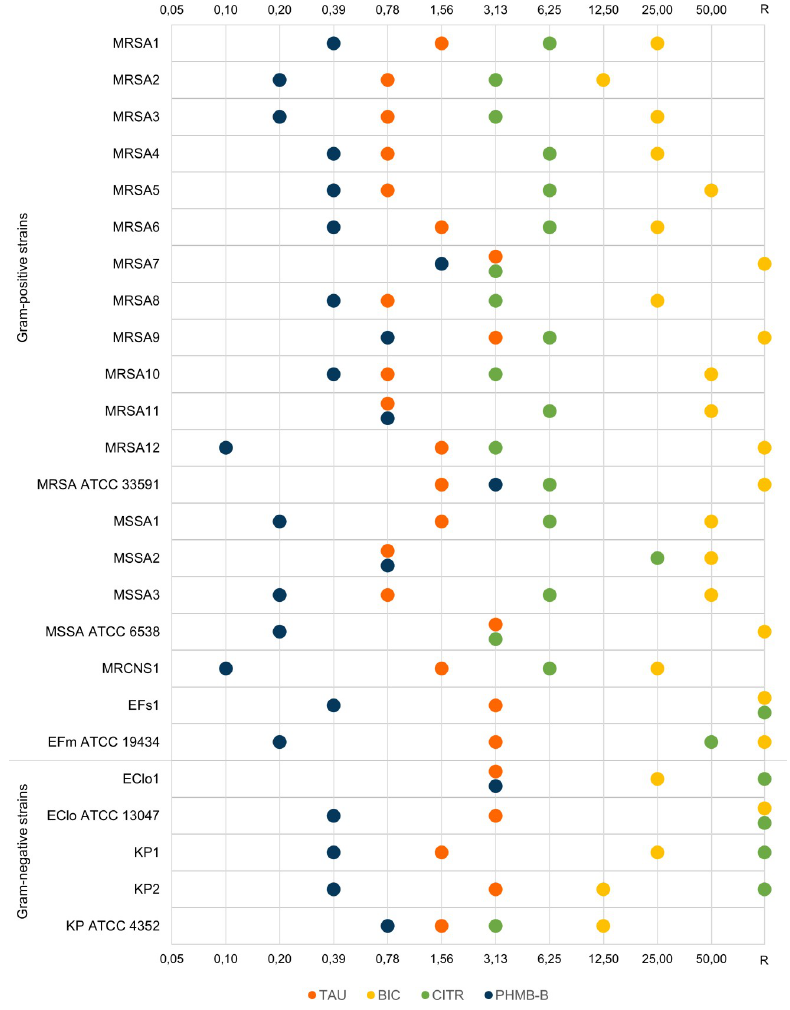
Fig 1. Minimum concentrations of preparations inhibiting the growth of bacteria (MIC). TAU–taurolidine, BIC– bicarbonate, CITR- trisodium citrate, PHMB-B–polyhexanide-betaine, R–no activity in the test concentration